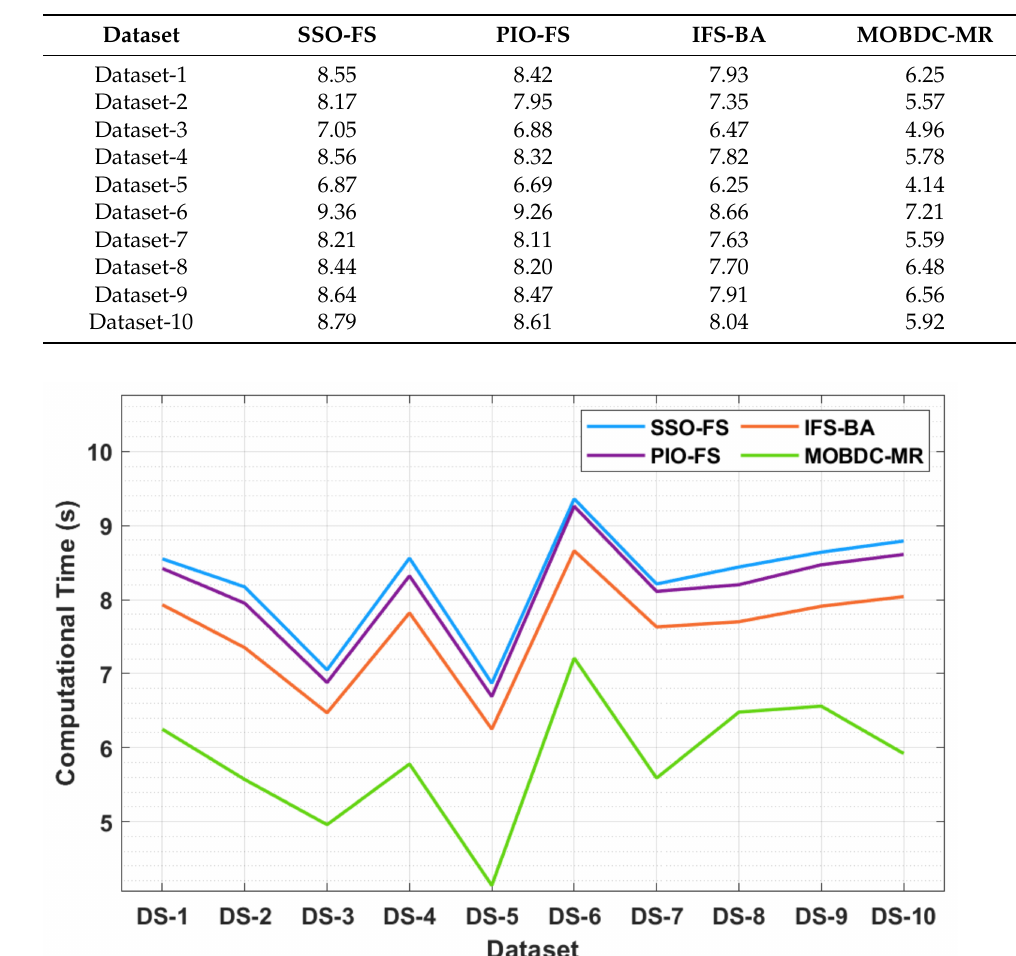
Figure 6. Computational time analysis of the MOBDC-MR